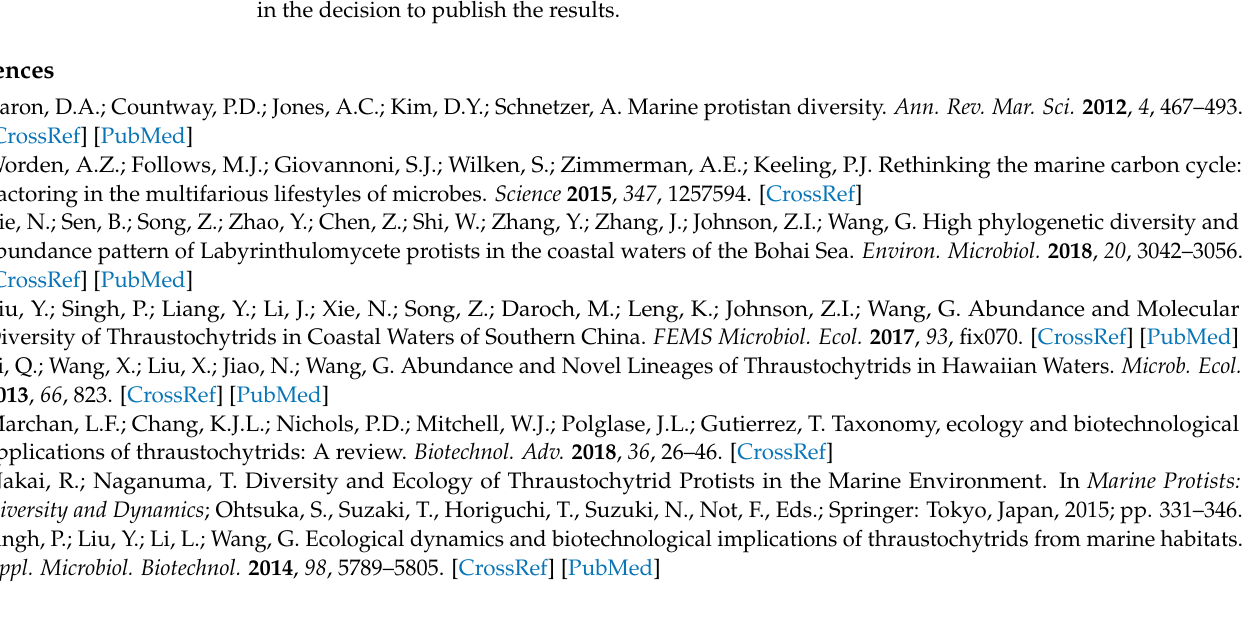
ciated. Table S1: Spearman’s rank correlation coefficients and p values between the abundance of LP and environmental factors; Table S2: Taxonomy of shared ASVs and their relative abundance; Table S3: Properties of the interaction network between Labyrinthulomycetes and Bacteria in the surface seawater; Table S4: Properties of the interaction network between Labyrinthulomycetes and Bacteria in the bottom